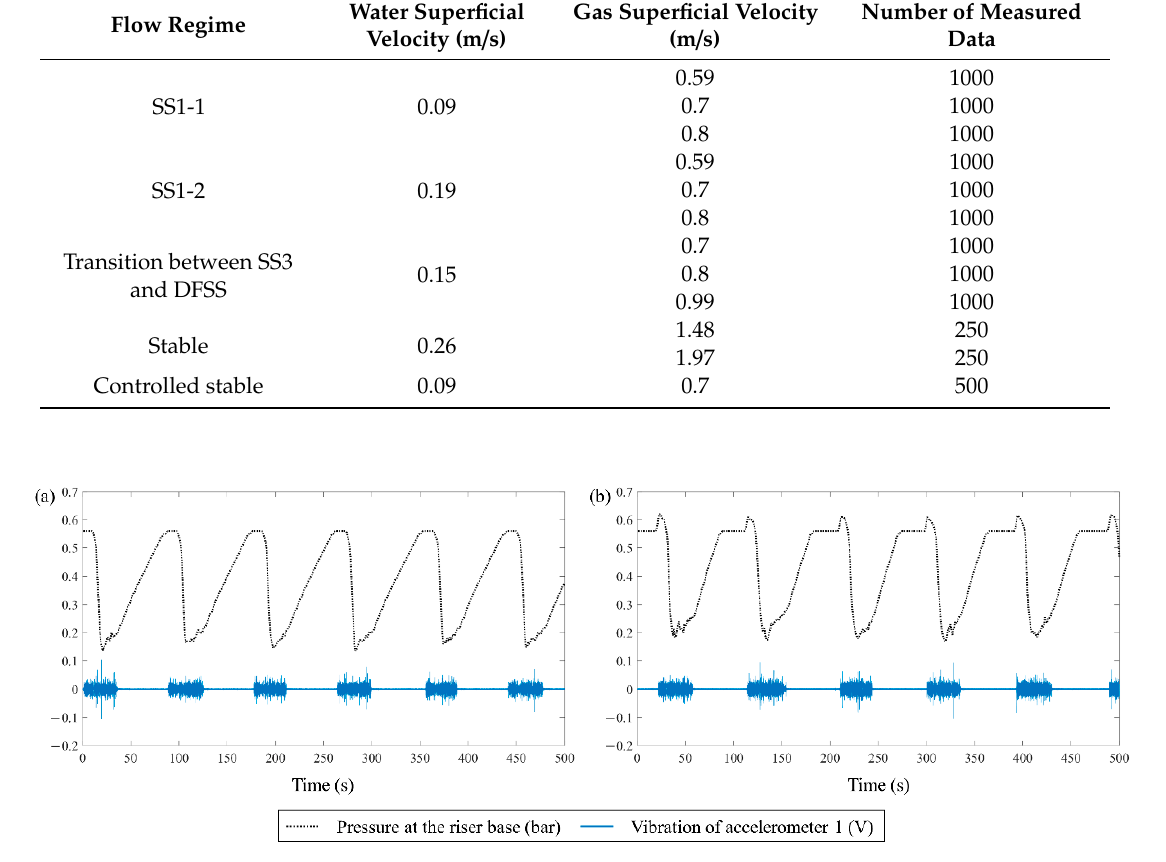
Figure 5. Comparison of the pressure at the riser base and the signals from accelerometer 1 for ( a ) SS1-1 at u SW = 0.09 m / s with u SG = 0.59 m / s and; ( b ) SS1-2 at u SW = 0.19 m / s with u SG = 0.59 m / s. The black dotted line indicates the pressure and the blue solid line indicates the vibration.